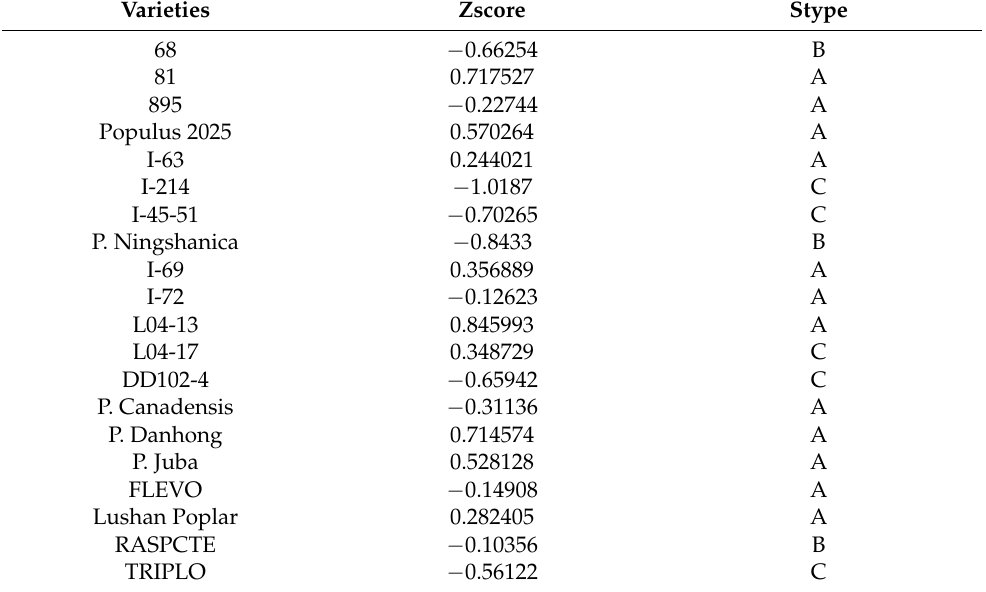
Table 6. Main information of varieties.